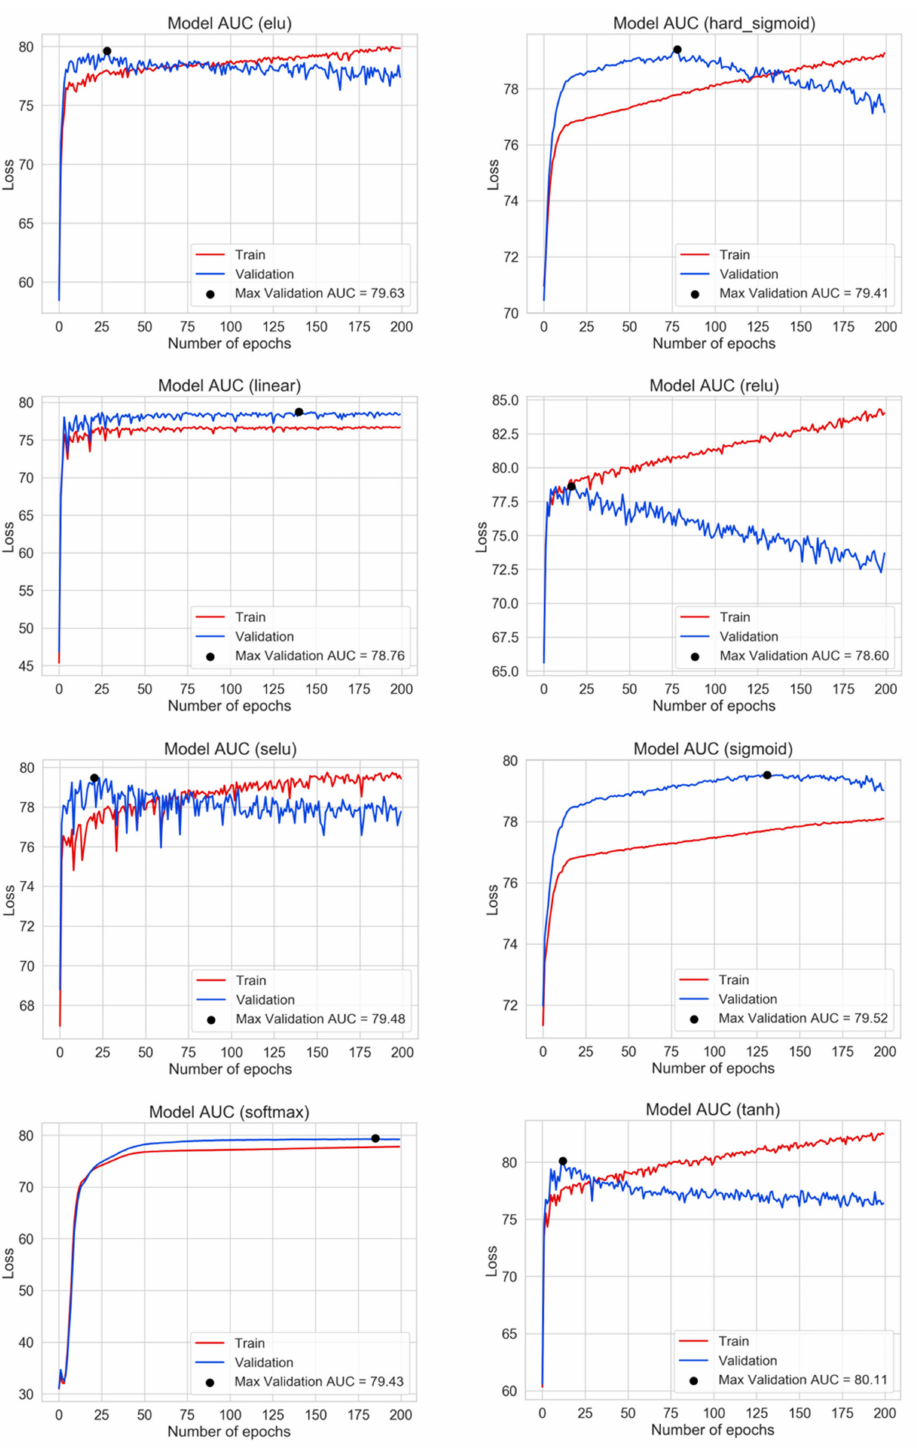
Figure 3. Comparison of area under curve (AUC) according to various activation